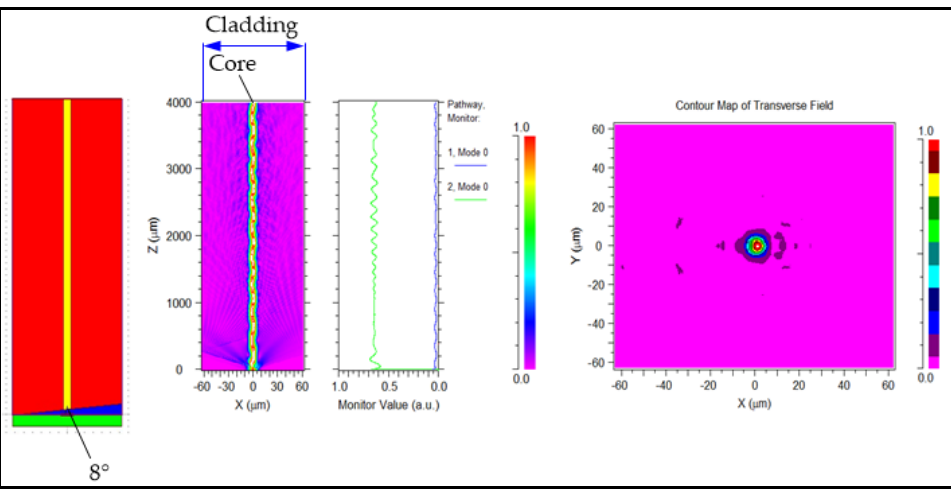
Figure 4. Optical field distribution in fiber with 8° end − face at the focal position (0,0,0).